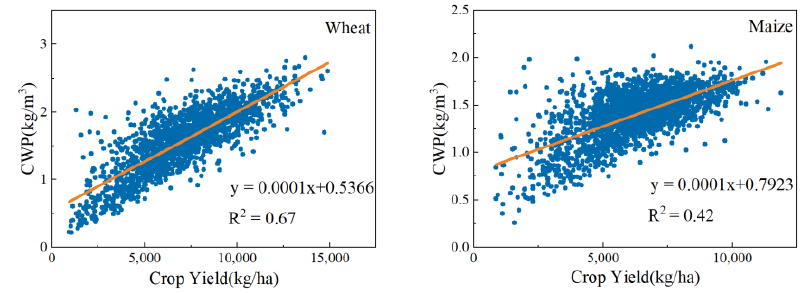
Figure 19. Relationship between CWP and crop